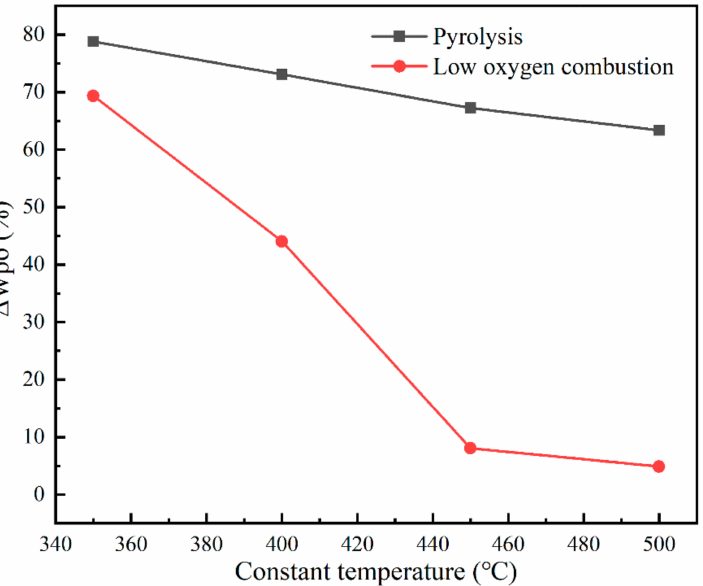
Figure 4. The variety law of the mass of combustible components, ∆ Wpo , in different constant